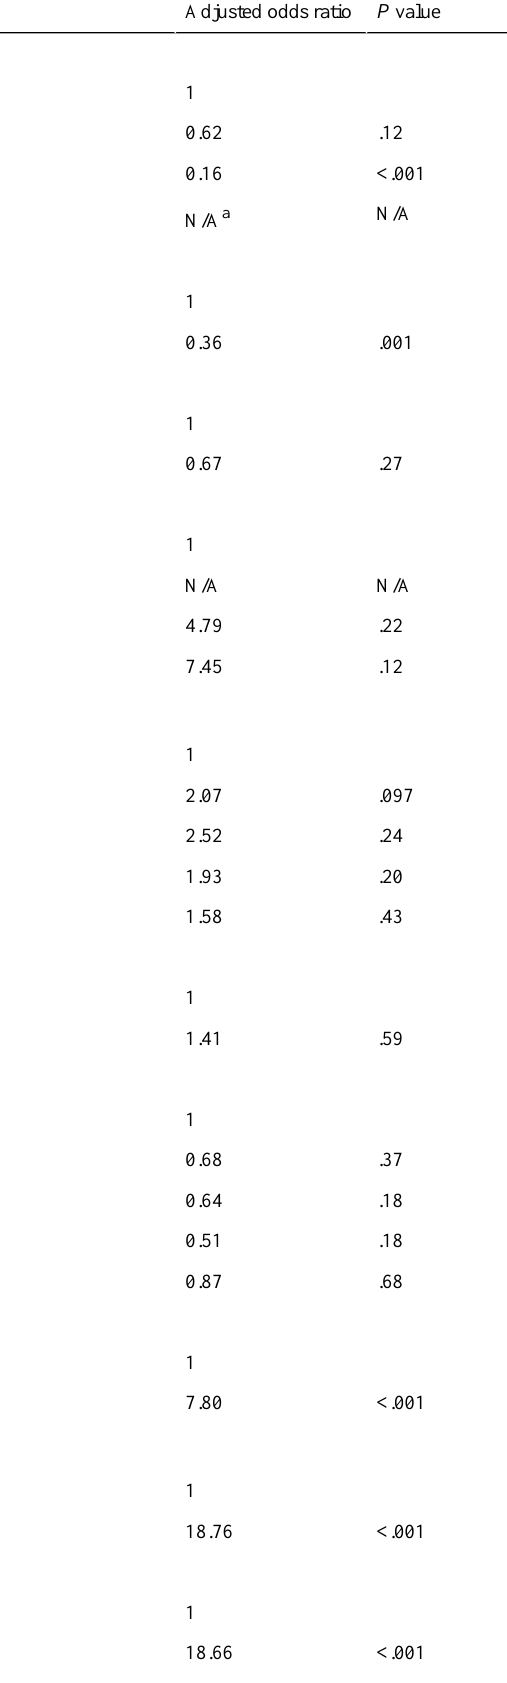
Table 8. Multivariable analysis of the association of daily step sync function with other functions. In this analysis, the outcome variable was daily steps